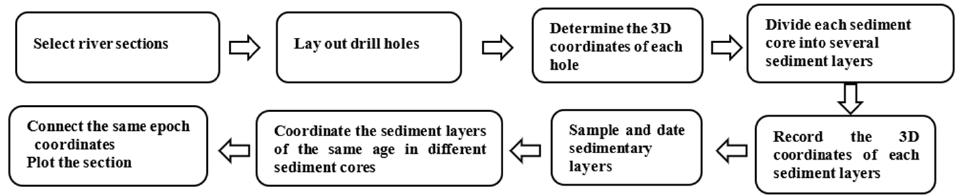
Figure 3. Conceptual diagram showing the restoration of historical river cross-sections.